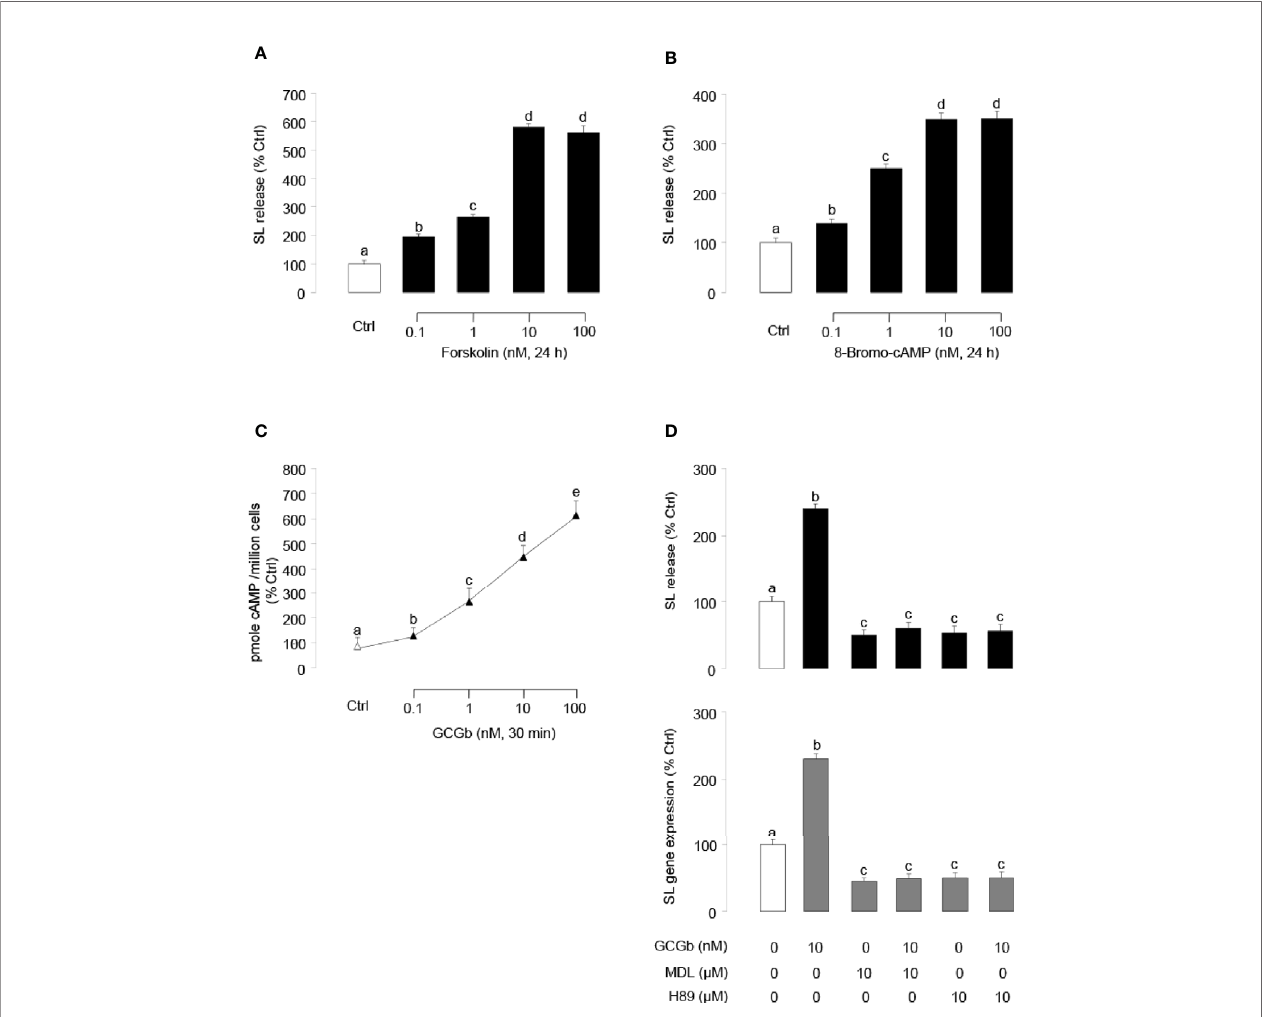
FIGURE 6 | Functional role of AC/cAMP/PKA-dependent mechanisms in SL release and gene expression. (A, B) Effects of activating cAMP-dependent cascades on SL release. NIL cells were treated for 24 h with increasing doses of (A) the AC activator forskolin (0.1 – 100 nM) or (B) the membrane-permeant cAMP analog 8- Bromo-cAMP (0.1 – 100 nM). (C) Effects of increasing concentrations of GCGb (0.1 – 100 nM) on total cAMP production in NIL cells. These data were normalized as a function of cell number (as “ picomole cAMP produced/million cells ” ). (D) Effects of MDL12330A and H89 on GCGb-induced SL release (upper panel) and mRNA expression (lower panel). NIL cells were incubated for 24 h with GCGb (10 nM) in the presence or absence of the AC inhibitor MDL12330A (MDL, 10 µM), or PKA inhibitor H89 (10 µM). All results are expressed as the mean ± SEM (N = 3) and different superscript letters in each column show signi fi cant differences ( P < 0.05, ANOVA followed by a Bonferroni ’ s